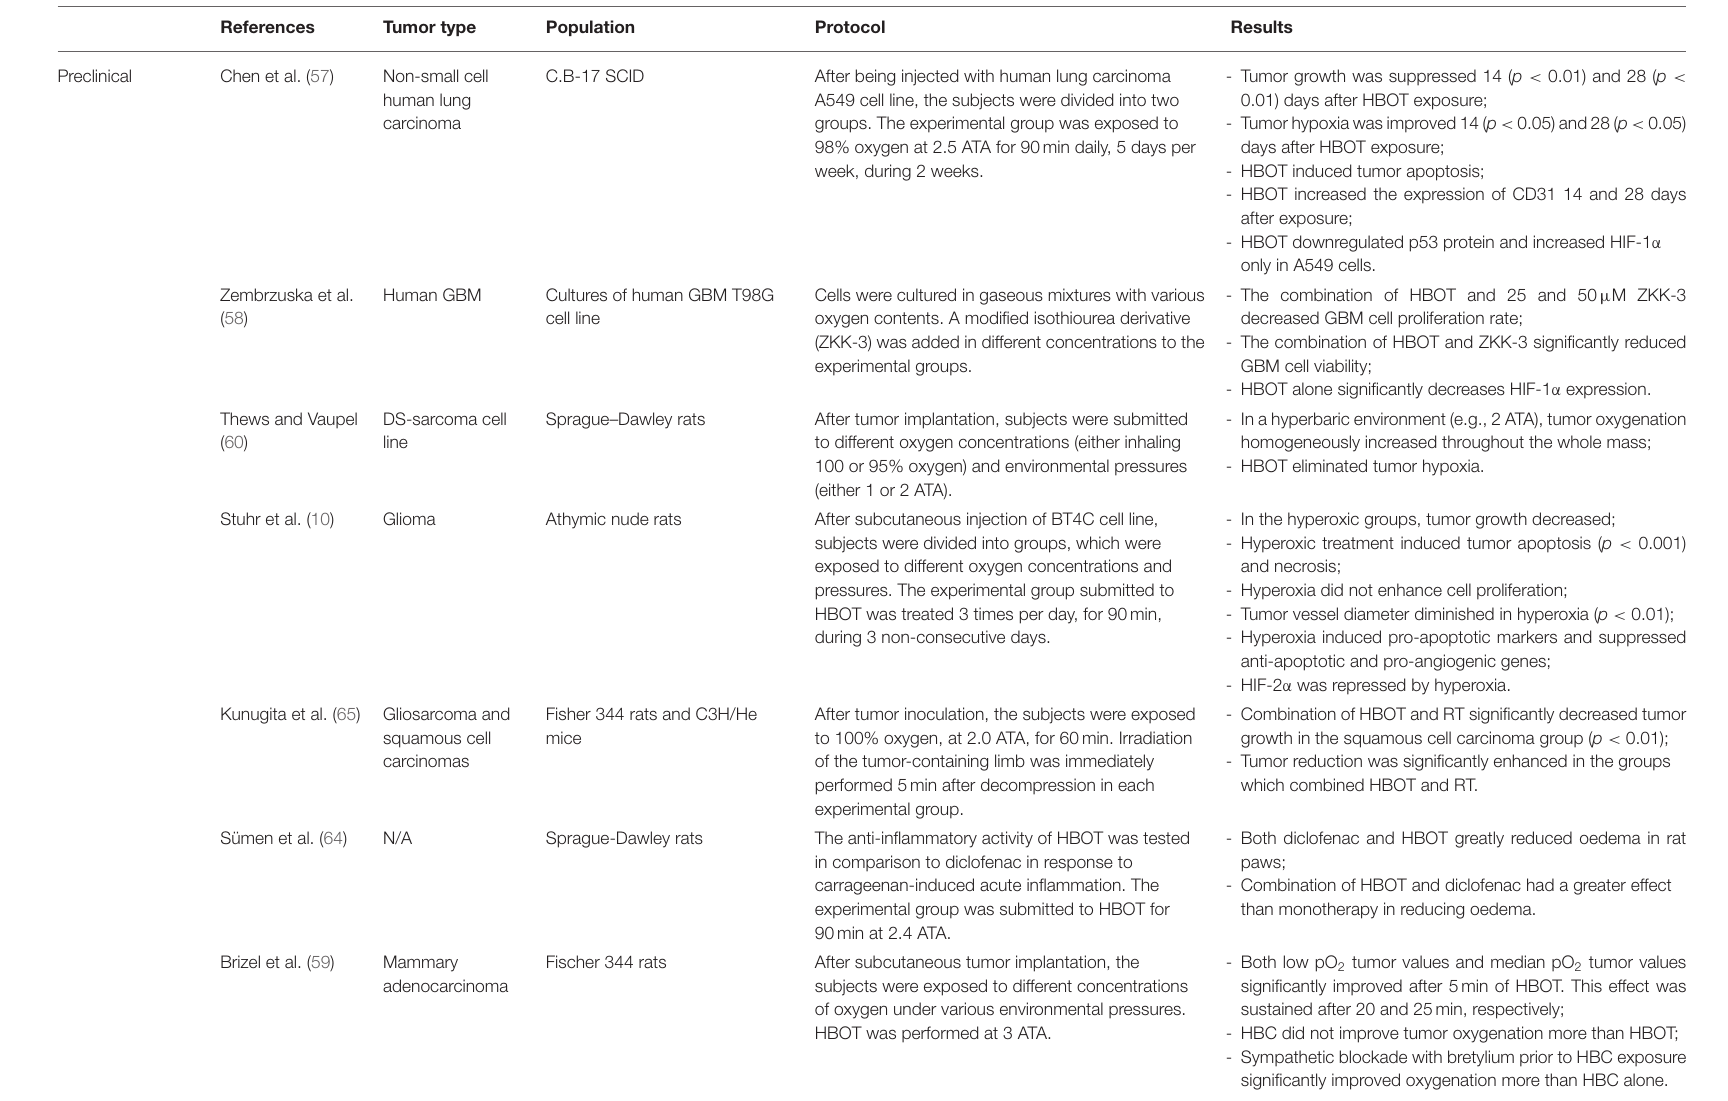
TABLE 1 | Summary of preclinical or clinical trials present in the literature, referring to the use of hyperbaric oxygen therapy in the treatment of gliomas and tumor cells, as well as in the carcinogenesis